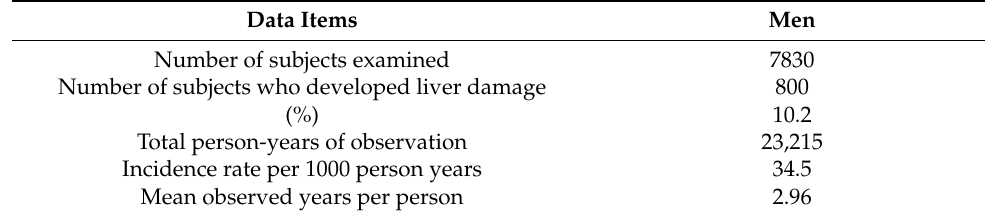
Table 3. Odds ratios and 95% confidence intervals for the development of liver damage in men. Men Independent Variables OR * (95% CI † ) p C-reactive protein 1.07 (1.03, 1.10) <0.001 Age (+1 y) 0.99 (0.98, 0.99) <0.001 Alcohol consumption (+1 gou/day) 1.46 (1.35, 1.59) <0.001 Body mass index (+1 kg/m 2 ) Mean blood pressure (+10 mmHg) High-density lipoprotein cholesterol 0.87 (0.76, 0.99) Meals (/Cooked by family ‡ ) Cooking by oneself Eating out or catering 0.89 (0.65, 1.21) Eating in a dormitory 0.86 (0.59, 1.26) 0.436 Others 1.68 (0.84, 3.36) 0.141 * Odds ratios adjusted for the effect of all other covariates using pooled logistic regression. † 95% confidence interval. ‡ Control categories. The data of C-reactive protein, high-density lipoprotein cholesterol, HbA1c, creatinine, and uric acid were logarithmically transformed using a base of 1.5. By forward stepwise method, selected potential covariates (which are shown in the above table) were adjusted for. Alcohol consumption (OR(95% CI): 1.46 (1.35–1.59)), BMI (OR(95% CI): 1.10 (1.07–1.13)), mean blood pressure for each 10 mmHg increase (OR(95%CI): 1.16 (1.06–1.26)), and